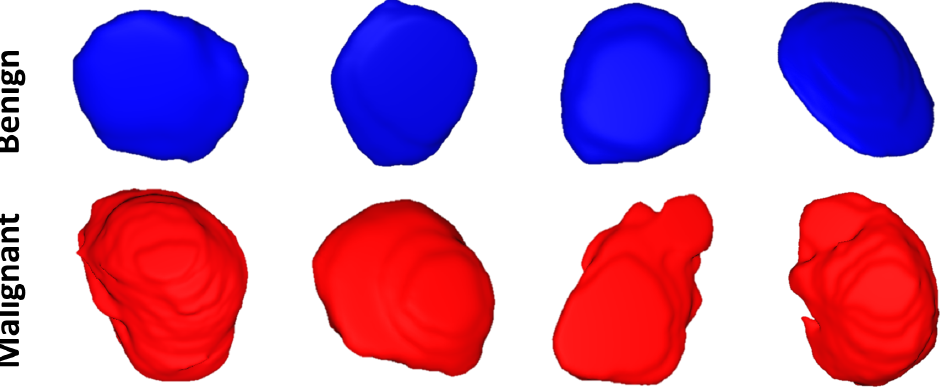
Figure 3. Visualizing 3D surface complexity differences between different renal tumors (benign are shown in blue, while malignant are shown in